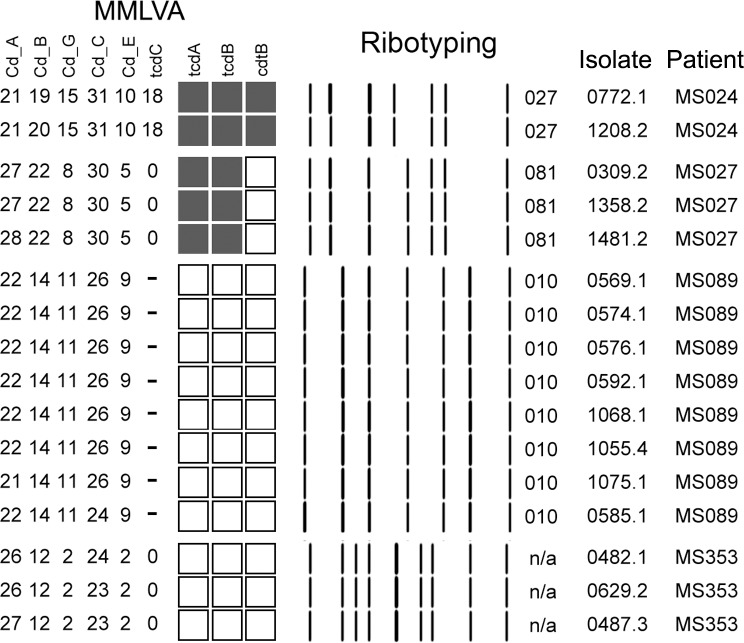
MMLVA profiles from multiple samplings.MMLVA analysis from multiple swabs collected on study participants over several days demonstrated that MMLVA profiling of CD isolates from the same patient over time were consistent and reliable (e.g. MS024, MS027, MS089 and MS353). MMLVA profiles of several specimens from MS024, MS027, MS089 and MS353 collected over time (range; swabs collected 8–67 days apart).